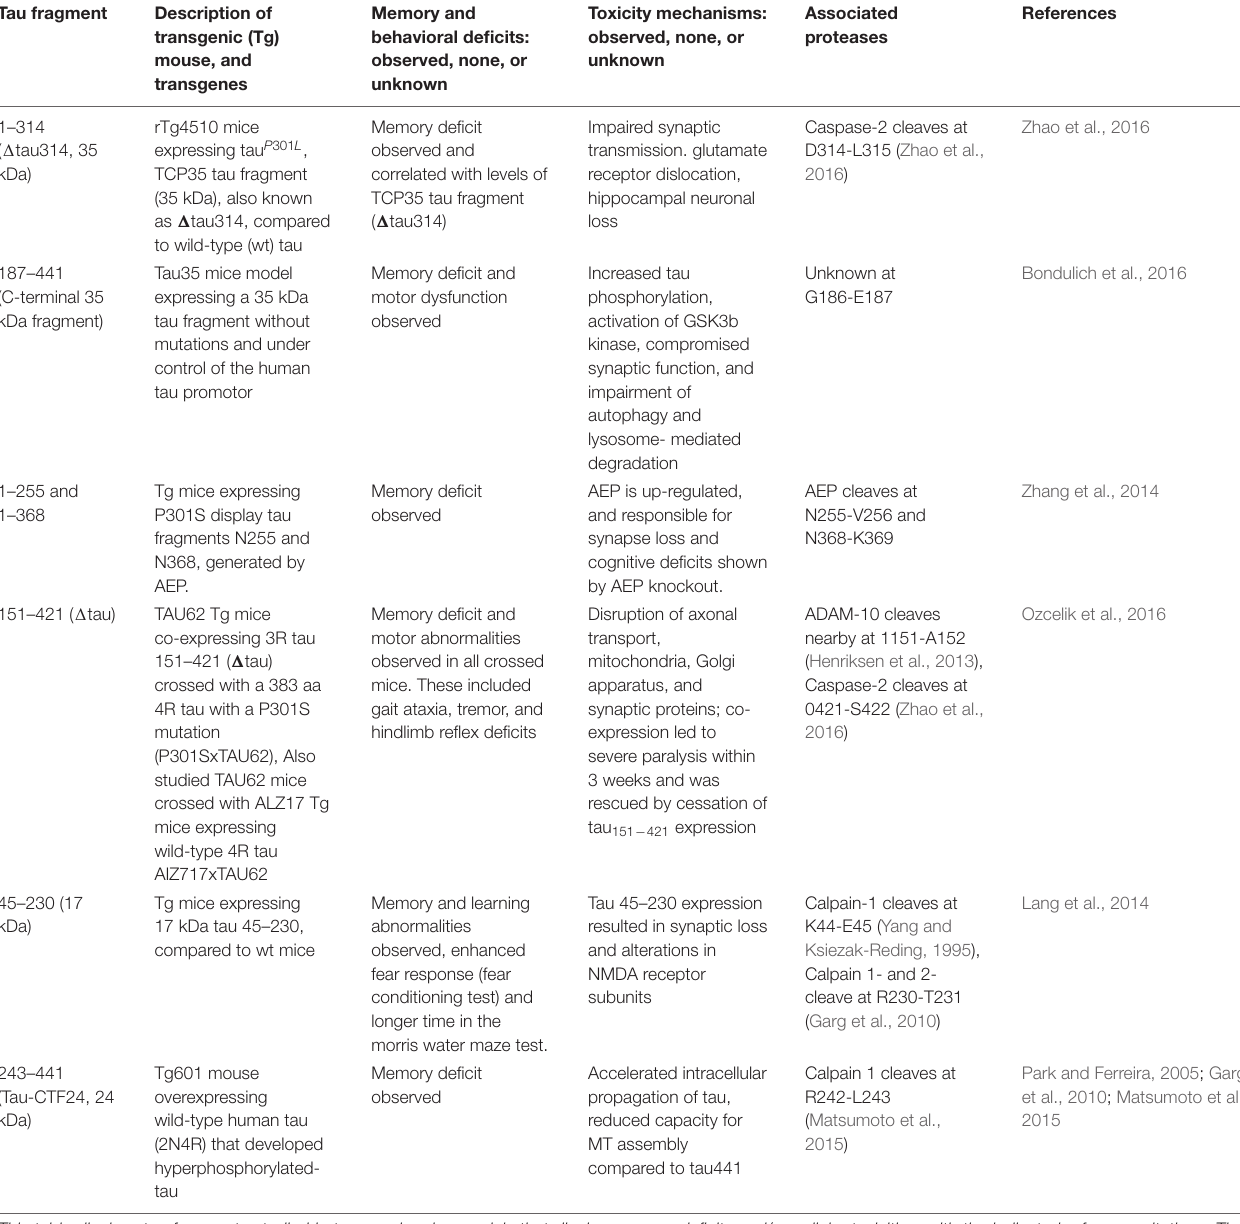
TABLE 1 | Tau fragments in in vivo models displaying memory deficits and/or cellular